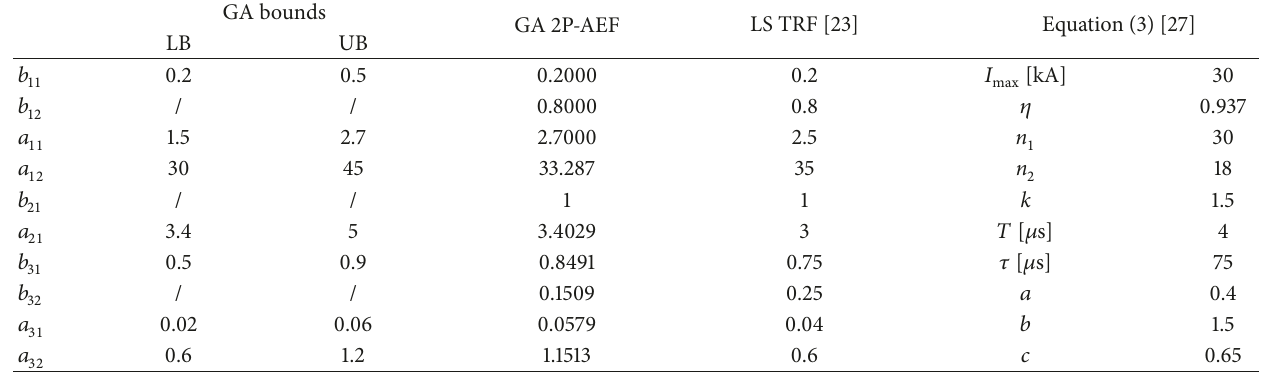
Table 3: Upper and lower bounds of the genome variables and parameters values for 2P-AEF, TRF, and current function (3).